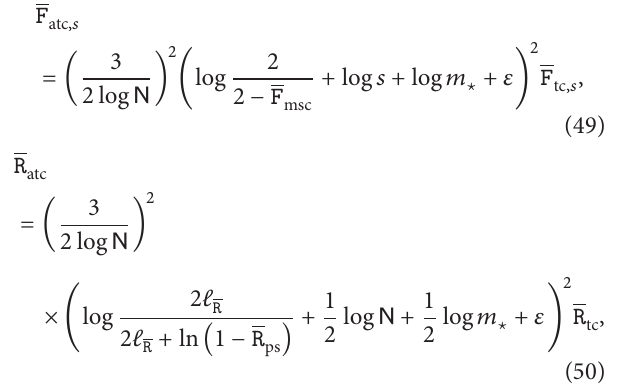
Note that the requirement log 𝑚 ⋆ + 2 log 𝑡 ⋆ ≈ log N